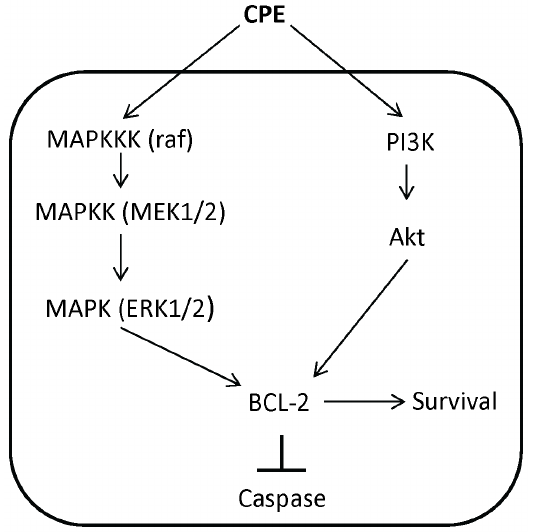
Figure 7. Mechanism of neuroprotection by CPE in primary cultured hippocampal neurons. CPE signals the MEK/ERK and PI3-K/ AKT signaling pathways which up-regulate the expression of the anti- apoptotic protein, BCL-2, and inhibit the caspase cascade leading to a decrease in cleaved caspase-3, the apoptotic executioner.